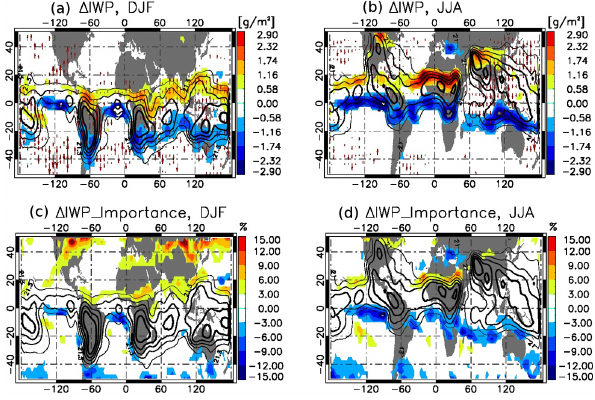
Figure 4. Same as Fig. 3, except using DARDAR v2.1.1 IWC prod- uct within the same altitude